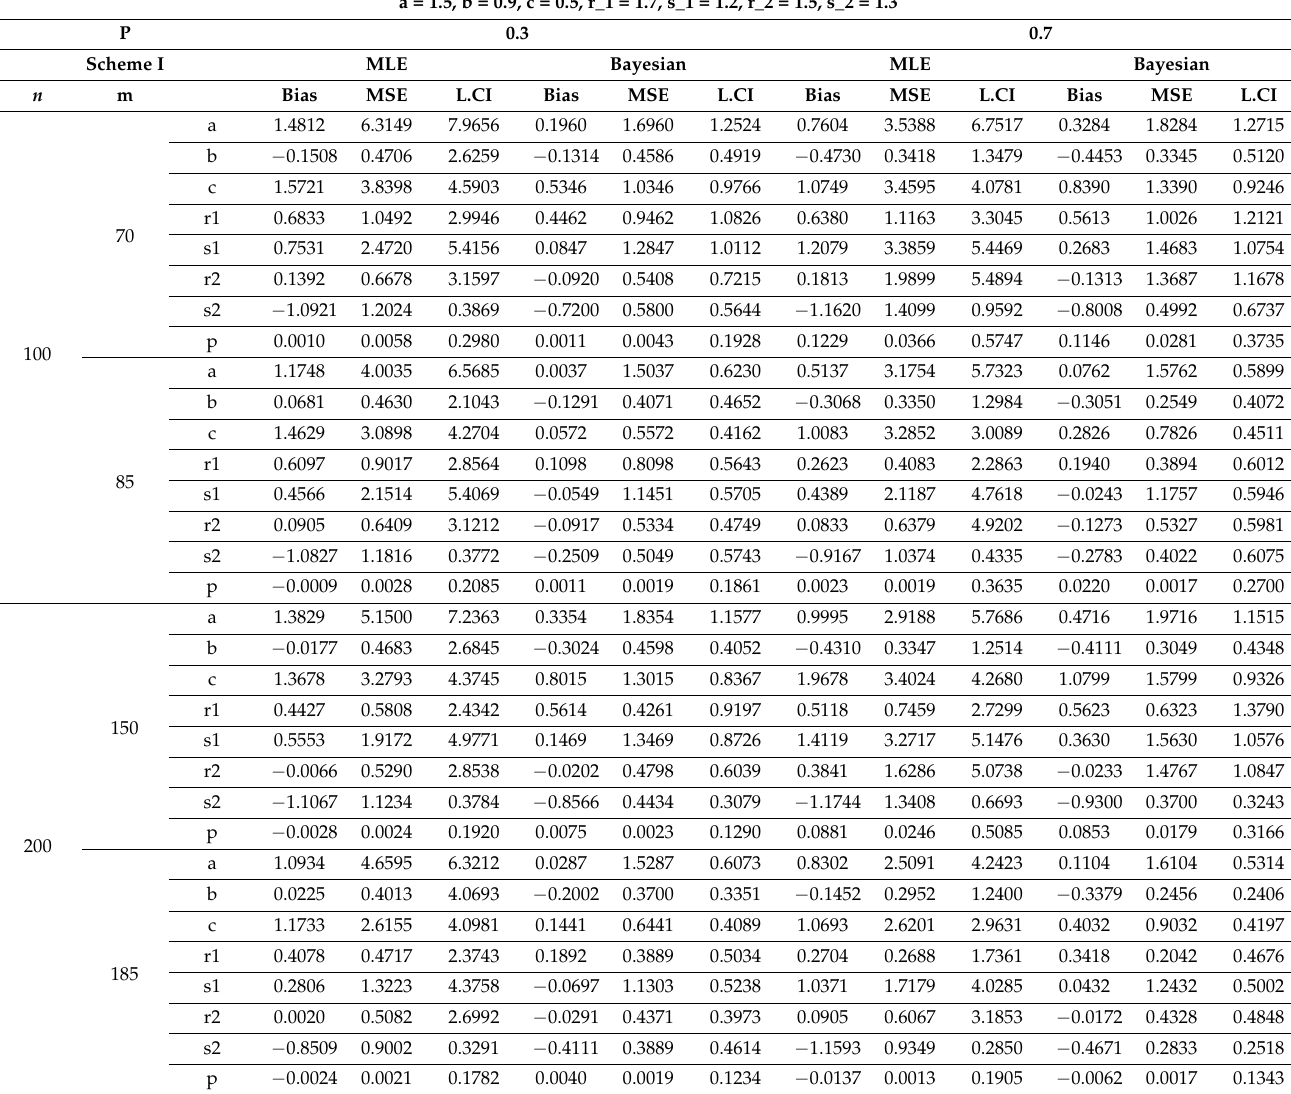
Table 2. MLE and the Bayesian estimates for eight parameters of MEKGEKF model based on a progressively type II censoring scheme: scheme